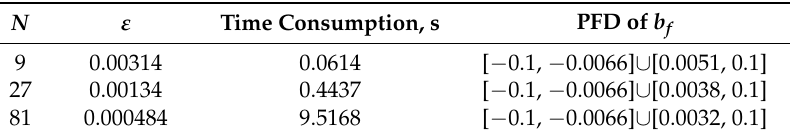
Table 2. Results of Method 1 for different scale benchmarks.